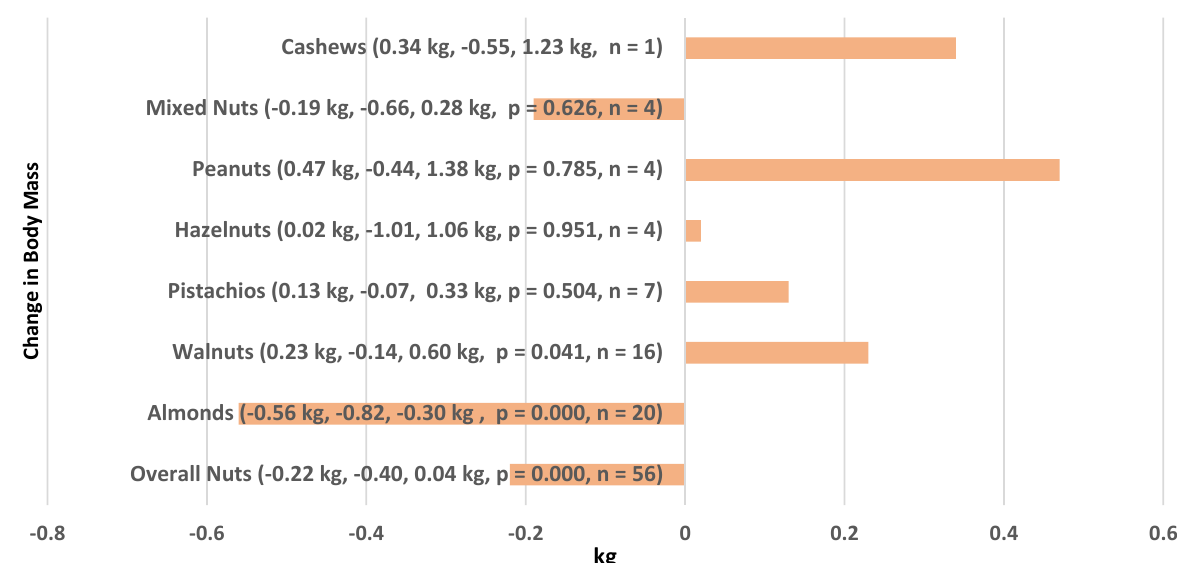
Figure 1. The effects of specific nut-enriched diets and overall nut intake on change in body mass compared to control diets based on a meta-analysis of 62 RCTs